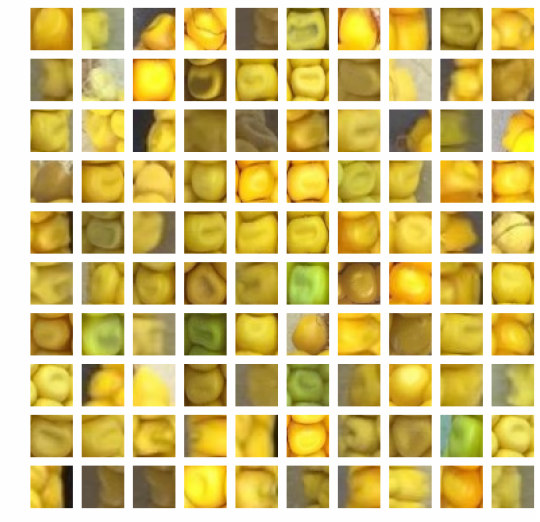
Figure 3. A random subset of kernel images.